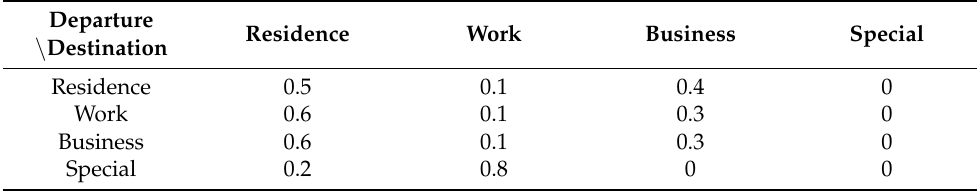
Table A2. OD matrix at 17:00~22:00 on weekdays.